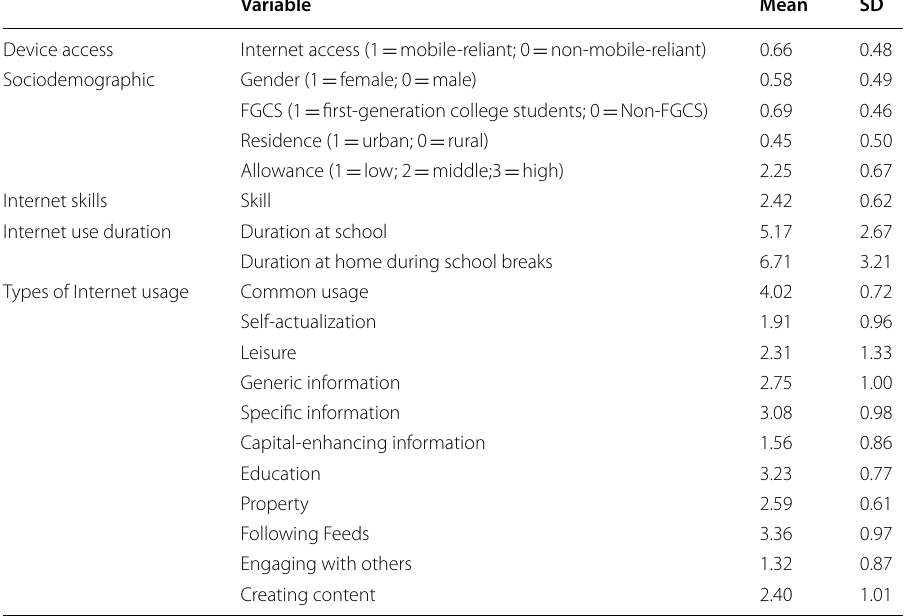
Table 1 Summary statistics